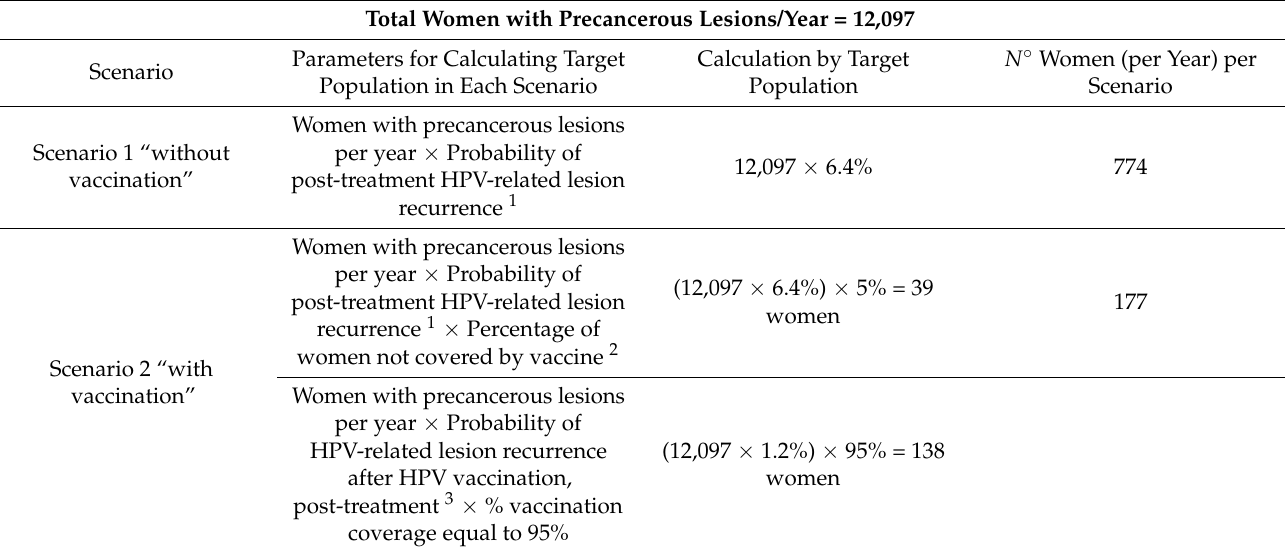
Table 3. Initial populations of the two scenarios under